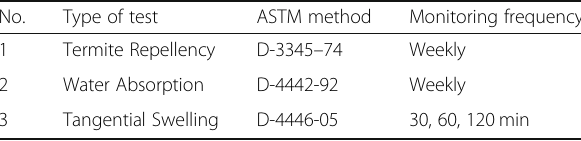
Table 3 The standard method used and frequency of